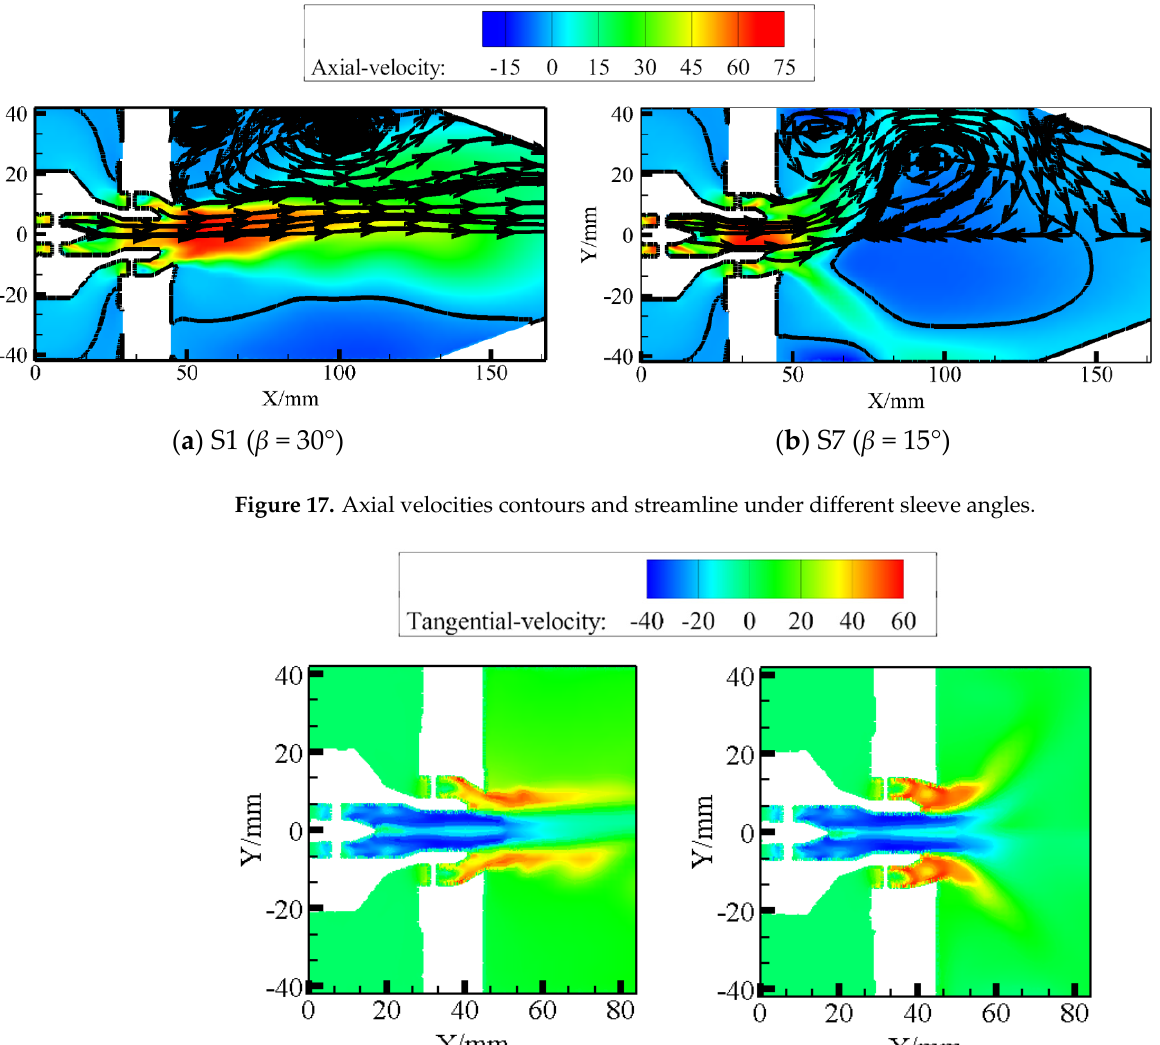
( d ) d = 60 mm Figure 19. Radial profiles of axial velocity.